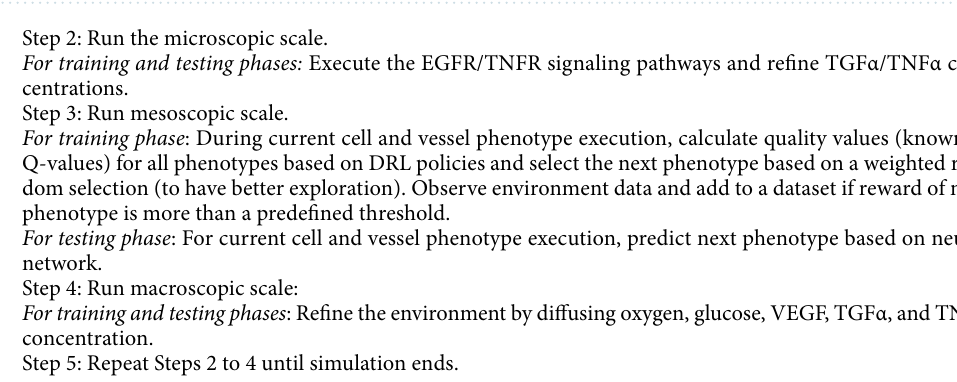
Figure 7. Flow chart detailing the deep reinforcement learning model for training and testing on patterns generated by the multiscale simulation for predicting tumor growth using input from medical image-derived